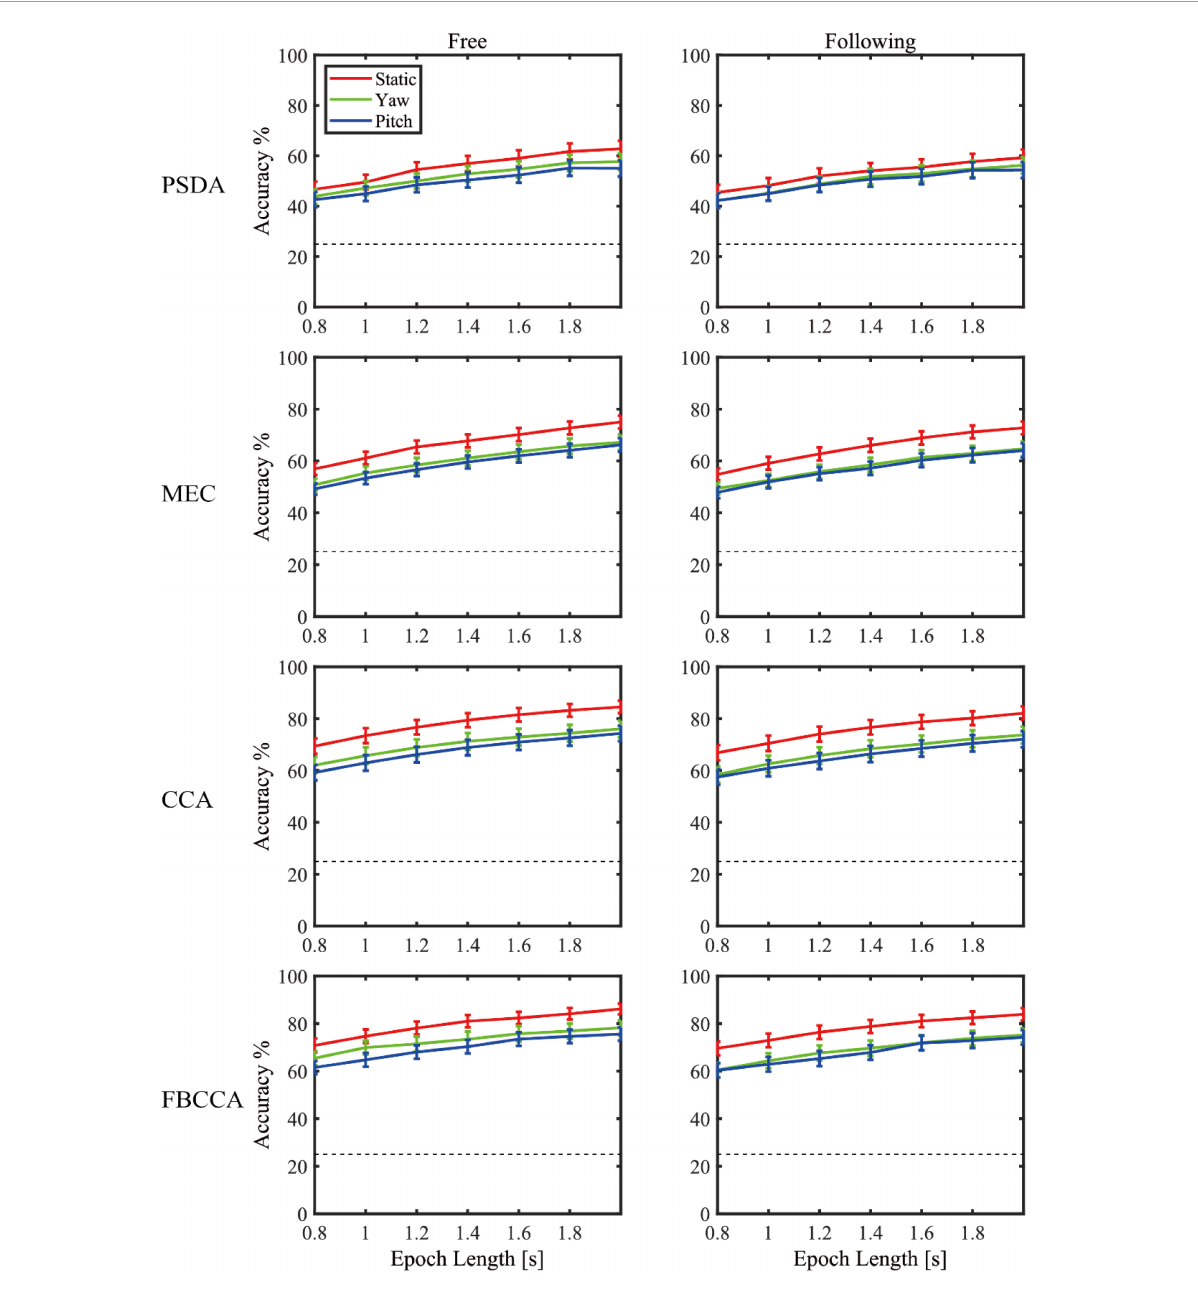
FIGURE8 The decoding accuracies with SEM as varying the window lengths in both moving tasks for each